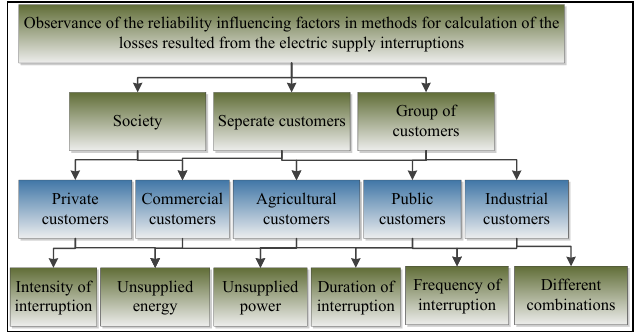
Fig. 1. Factors influencing the losses from electric supply